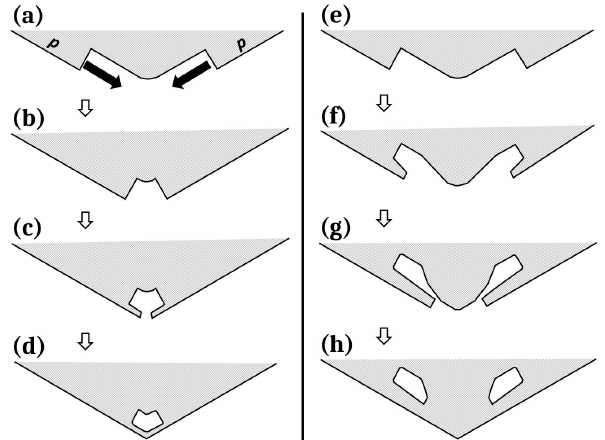
Figure 10. Edge-type pocket formation between prism faces. (a) Each prism face has a large advancing front or side face growing laterally towards the edge. This lateral growth is marked by the solid arrows and is driven by both direct vapor flux and the AST flux. (b) The two large fronts are close enough to effectively “shadow” the inside edge from the vapor flux (these fronts may also be non- crystallographic). (c) Vapor gradients along the front lead to pro- truding growth, driven by AST. (d) Protrusions merge, making an edge-type pocket. Case (e) – (h) is similar except with greater normal